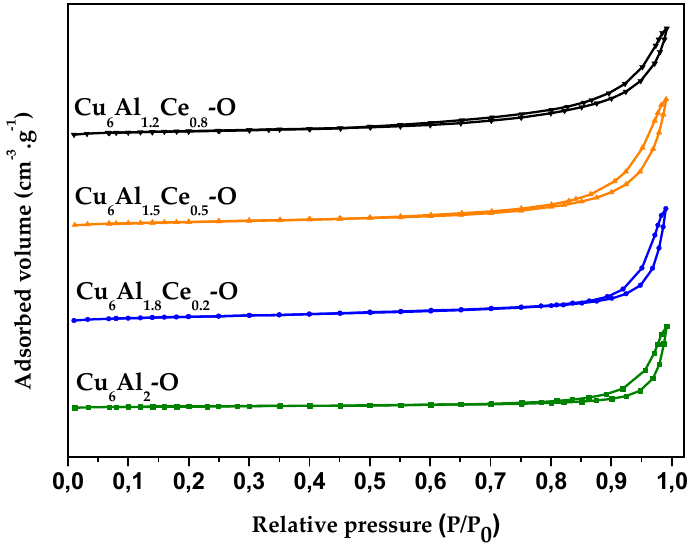
Figure 2. N 2 adsorption / desorption isotherms of Cu 6 Al 2-x Ce x -O samples.